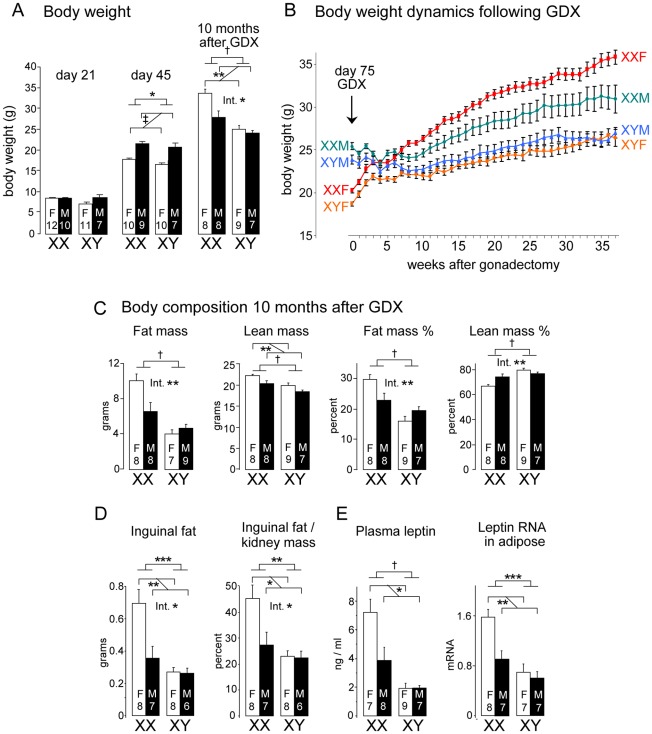
Increased body weight and fat mass in XX versus XY mice on a chow diet.(A) Body weight of four core genotype (FCG) mice at day 21 and day 45, prior to gonadectomy (GDX), and at 10 months after GDX. F, gonadal female; M, gonadal male. Values represent the mean ± SEM for the number of animals indicated in each bar. Significant comparisons for sex chromosome complement and for gonadal sex are denoted by brackets. A significant interaction of sex chromosome complement and gonadal sex is denoted by “Int.”. The p values are as described at the end of the legend. (B) Body weight curve for FCG mice from the point of gonadectomy through 10 months following gonadectomy. Values represent mean ± SEM. Values are significantly different between mice with XX vs. XY genotypes beginning at week 7 following GDX and beyond that. (C) Body composition of mice in panel (B) determined by NMR in FCG mice at 10 months after GDX. (D) Fat pad mass in mice from panel (B) at 10 months following GDX expressed as absolute mass (grams) or relative to kidney weight, which is invariant among the genotypes. (E) Plasma leptin levels and leptin mRNA levels in inguinal adipose tissue. *, p<0.05; **, p<0.01; ***, p<0.001; †, p<0.0001; ‡, p<0.000001.